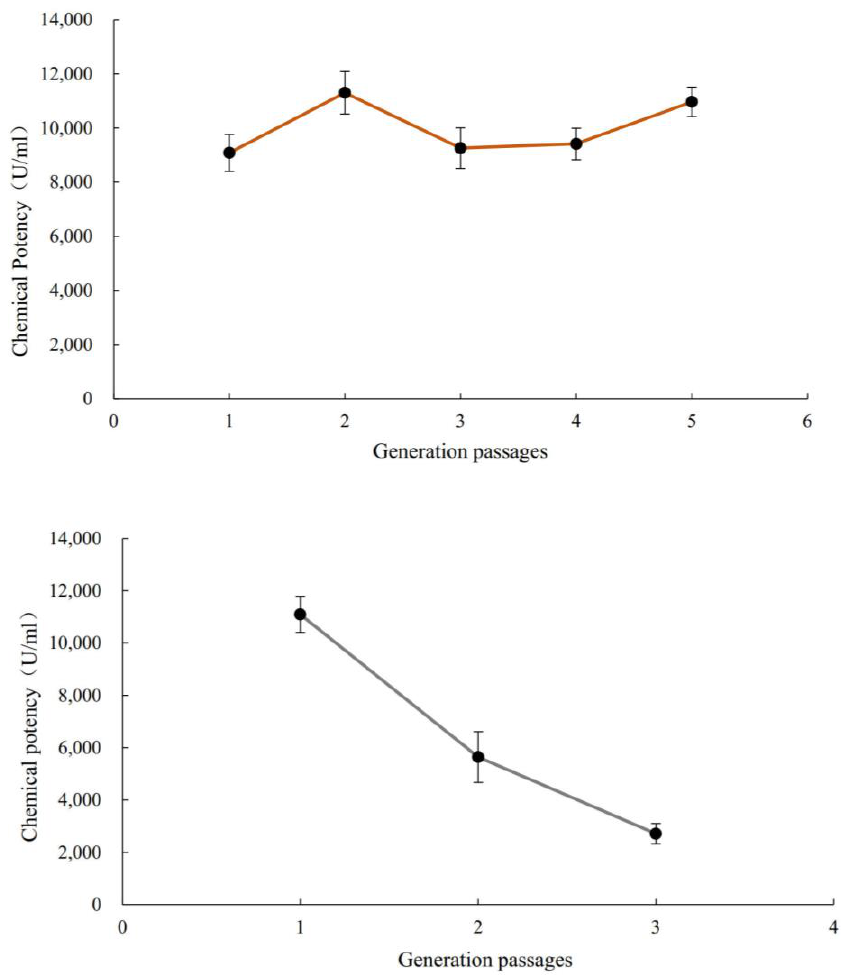
Figure 4. Genetic stability experiment results for Streptomyces noursei 72-22-1 and 112-24-63.